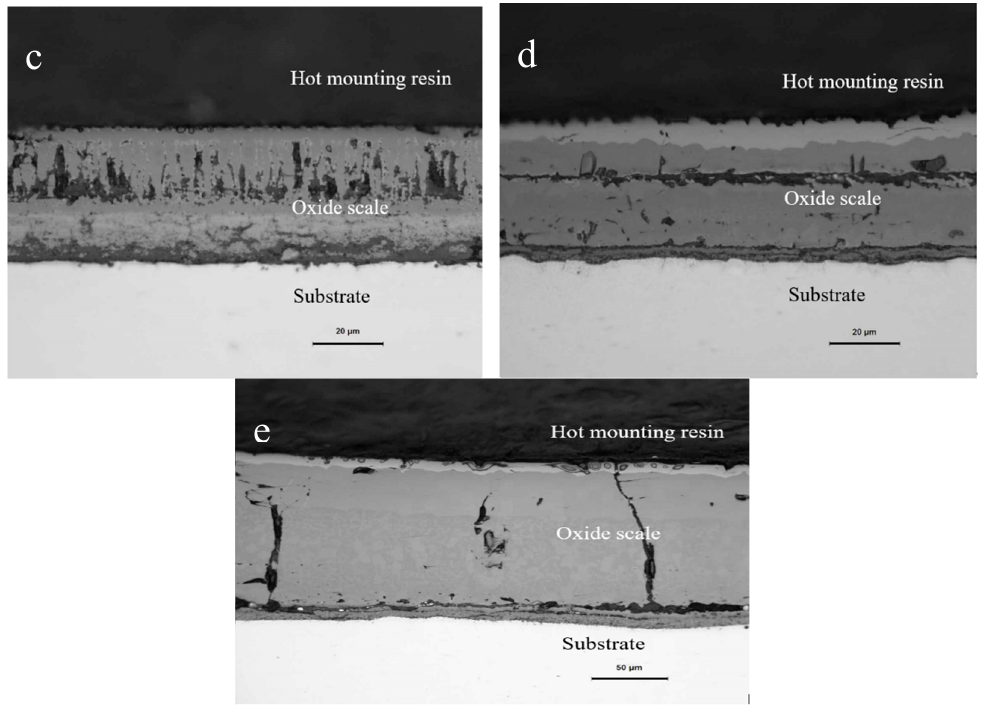
Figure 5. Cross-sectional morphology of the specimens observed under the metallurgical microscope.